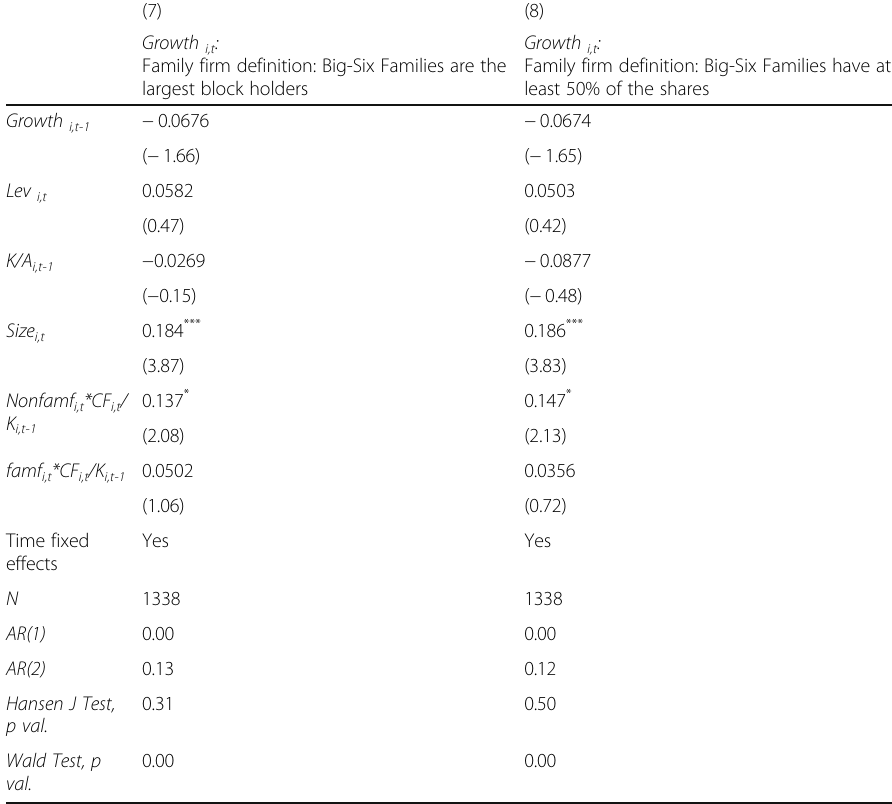
Table 6 GMM Estimation Results for Big-Six Families (7) (8) Growth i,t : Family firm definition: Big-Six Families are